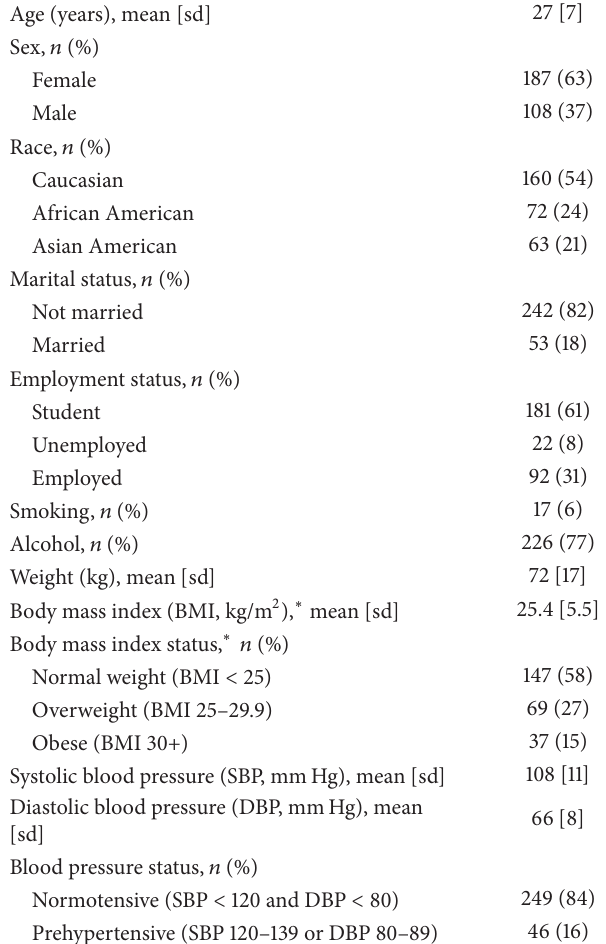
Table 1: Summary of study subject characteristics ( 𝑁 = 295, except where